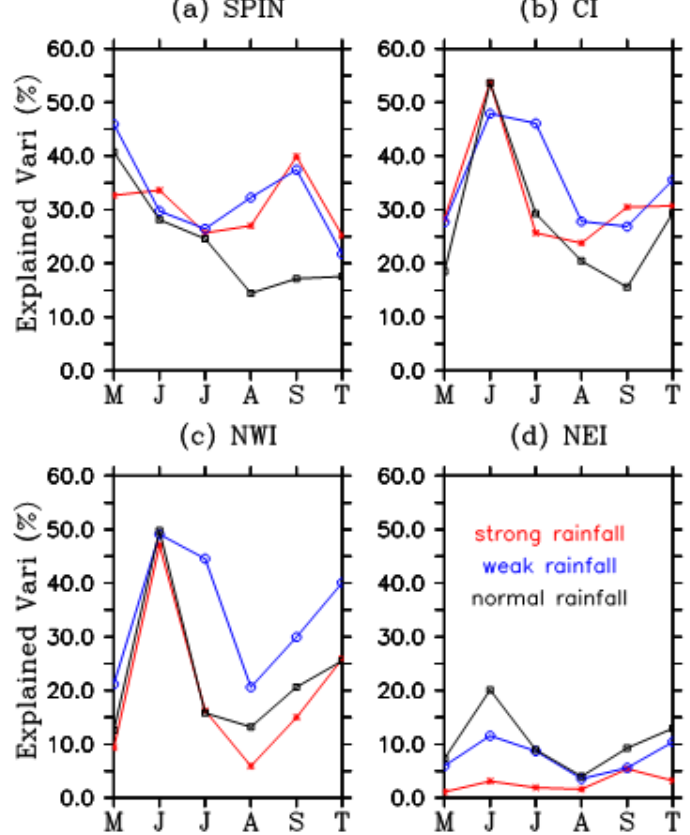
Figure 8. Explained variance based on a linear regression for spatially averaged daily SM regressed on spatially averaged daily rainfall during May, June, July, August, September, and June-September (JJAS, denoted by T in x-axis) of strong (red), weak (blue), and normal (black) ISMs over ( a ) SPIN, ( b ) CI, ( c ) NWI, and ( d ) NEI.